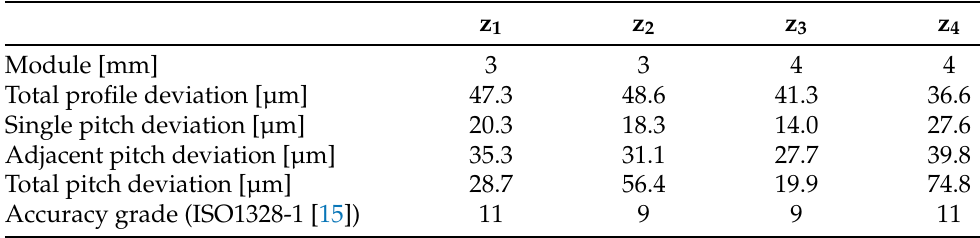
Table 1. Parameters of gear measurement of an intact gearbox.